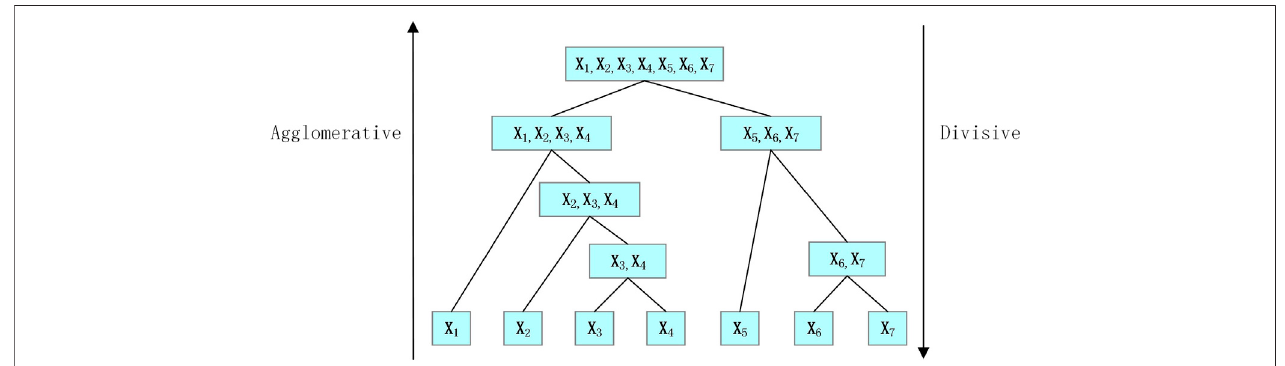
FIGURE 9 | Hierarchical clustering